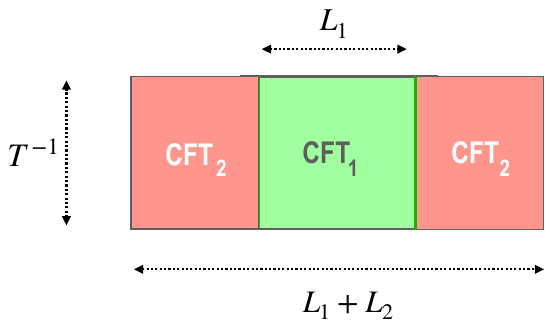
Figure 2 . The finite-temperature interface CFT at the AdS boundary. Both space and Euclidean time are compact, so the depicted surface is an orthogonal